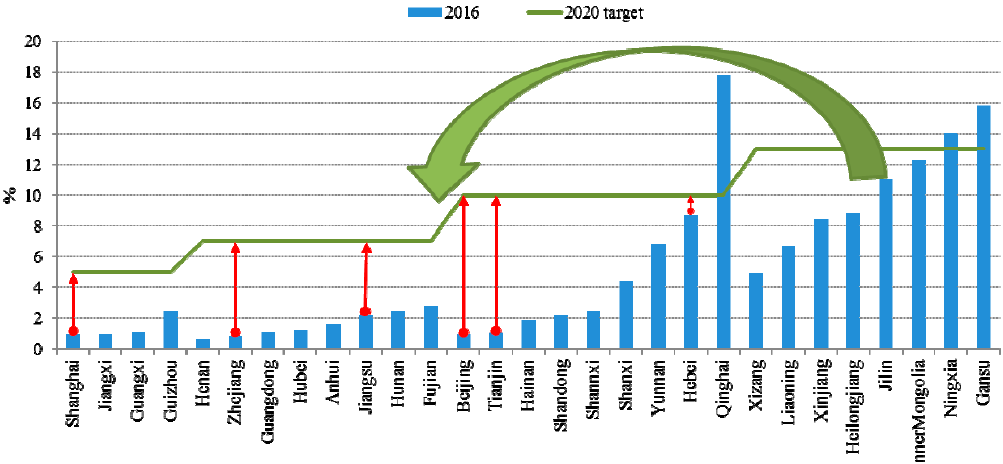
Figure 1. Percentage of non-hydro renewable energy in electricity generated in 2016 compared to the regional 2020 targets [3], with an indication of possible regional power exchanges.